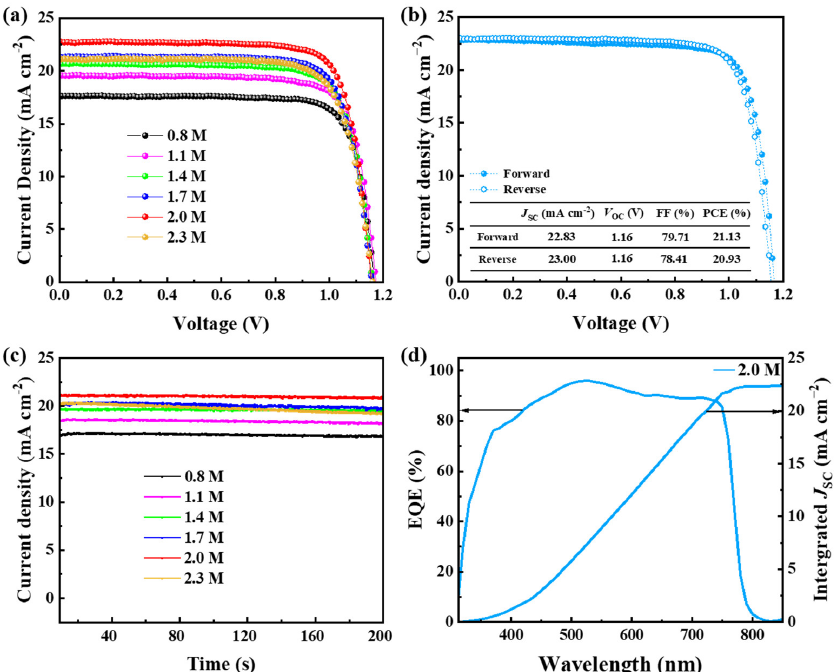
Figure 4. Performance characteristics of PSCs. ( a ) Current–voltage characteristic curves of devices with different precursor concentrations. ( b ) Current–voltage characteristic curves (including forward and reverse scan) of champion PSC. ( c ) Maximum power point (MPP) tracking of PSCs. ( d ) EQE spectra and corresponding integrated J SC of the device with 2.0 M precursor concentrations. The distribution of PCE, J SC , V OC , FF is intuitively shown in Figure 5, which are selected from eight groups of the same experiments. The obvious variation parameters are J SC and PCE. The change in J SC is ascribed to the increase in crystallization quality and film thickness, and is consistent with the analysis of perovskite film properties above.